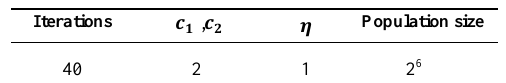
Table 2. Specifications of PSO.